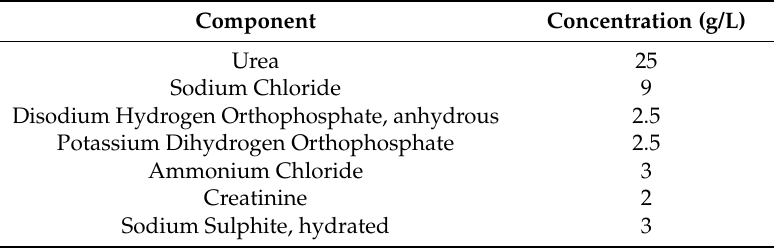
Table 1. Chemical composition of synthetic urine. The following table indicates the known concentration (g/L) of various components present in synthetic urine processed from Pickering Laboratories,